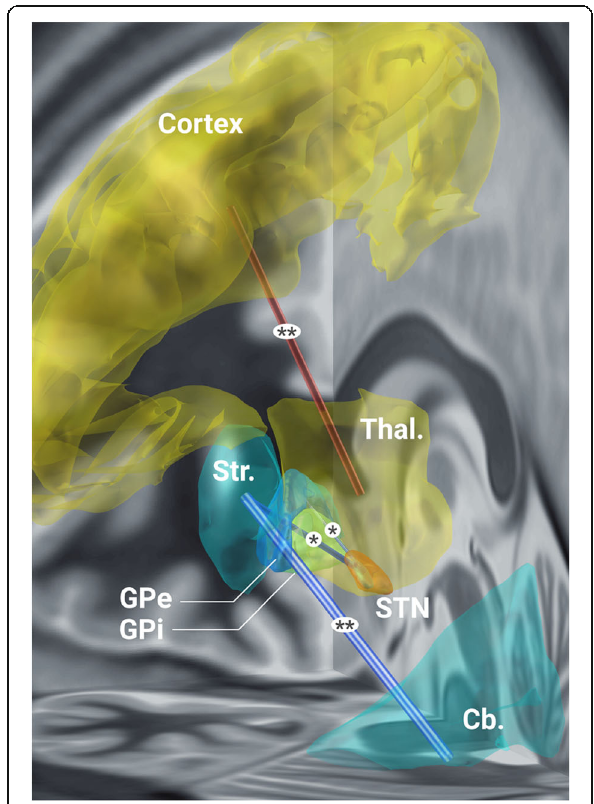
Fig. 4 Modulation of specific connections in the motor network by effective STN DBS. Functional connectivity increased between motor thalamus and motor cortex as a function of DBS impact on motor STN. Connectivity decreased between the motor STN and motor striatum or motor external globus pallidus (GPe) and between the motor striatum and cerebellum [** p < 0.005, * p < 0.05 corrected for multiple comparisons using the network-based statistical